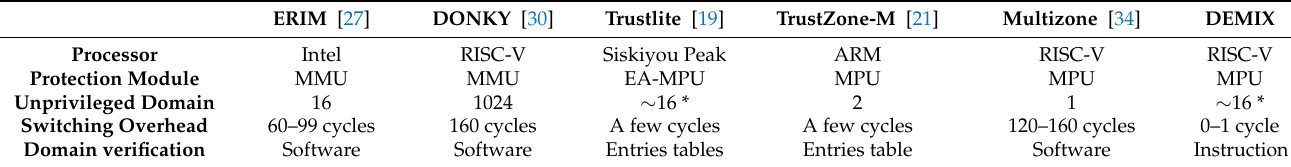
Table 2. Domain-switching overhead